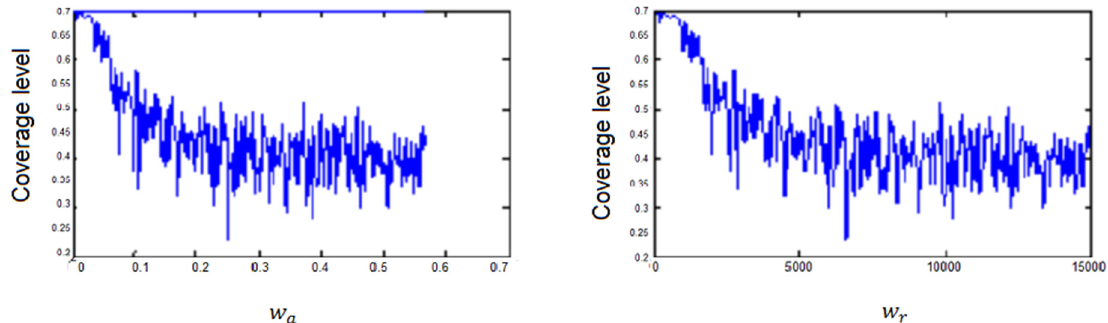
Figure 7. Coverage level achieved for different settings of w a and w r . The number of nodes = 50, D th = 20, and area size = 150 × 150 m.